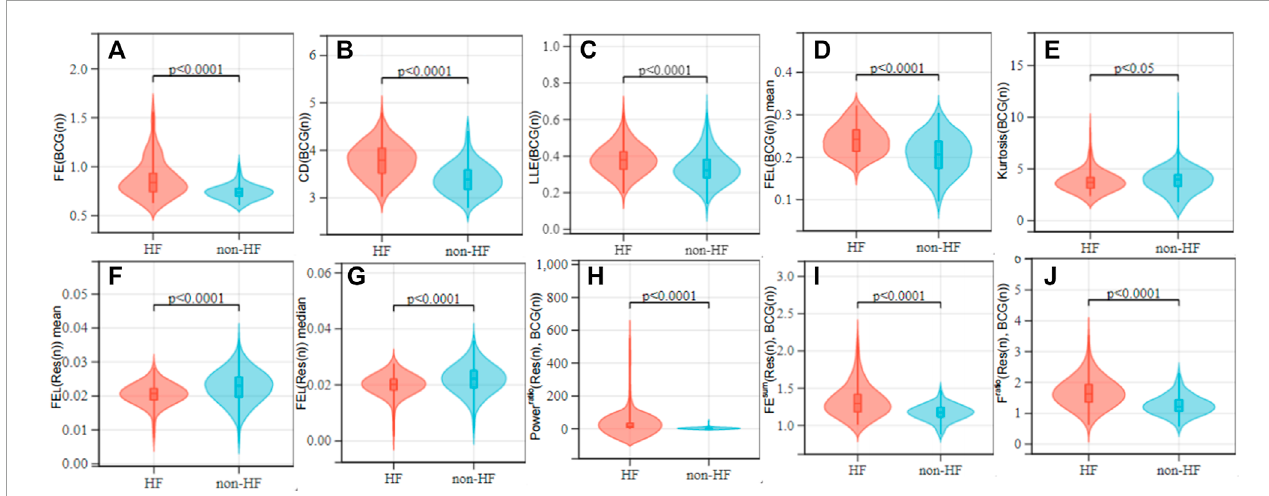
FIGURE 7 Value distribution of each feature over the HF and non-HF classes. (A – E) are BCG features; (F , G) are respiratory signal features; (H – J) are cardiopulmonary features. Non-parametric tests were used between